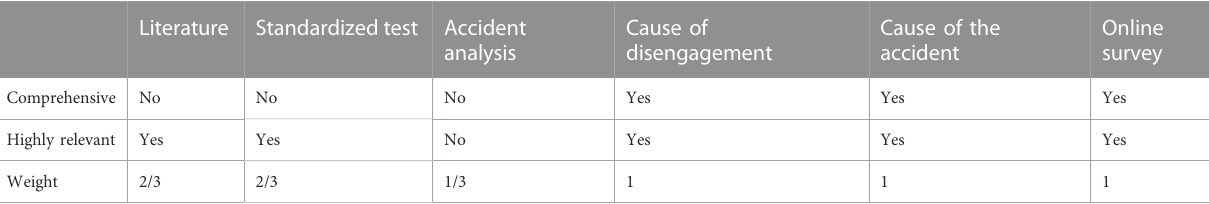
TABLE 3 Evaluation and weight de fi nition of features corresponding to different